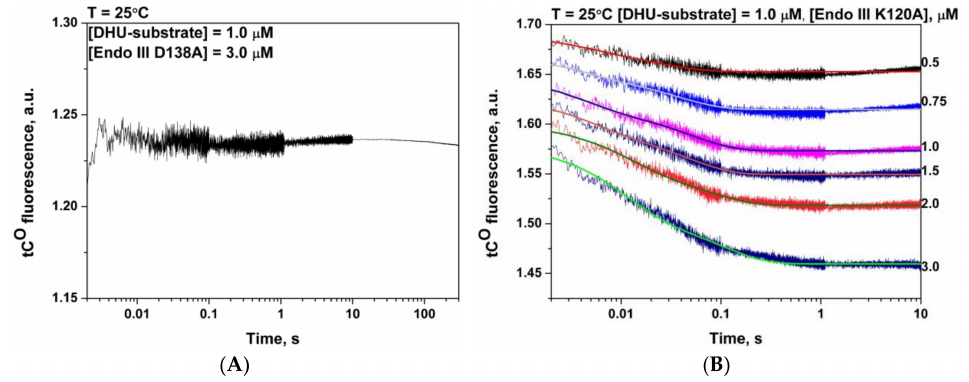
Figure 7. Changes in tC O fluorescence intensity during the interaction of Endo III D138A ( A ) or Endo III K120A ( B ) with DHU-substrate (1 µ M) at 25 ◦ C. Solid curves represent the curves fitted via the binding steps of Scheme